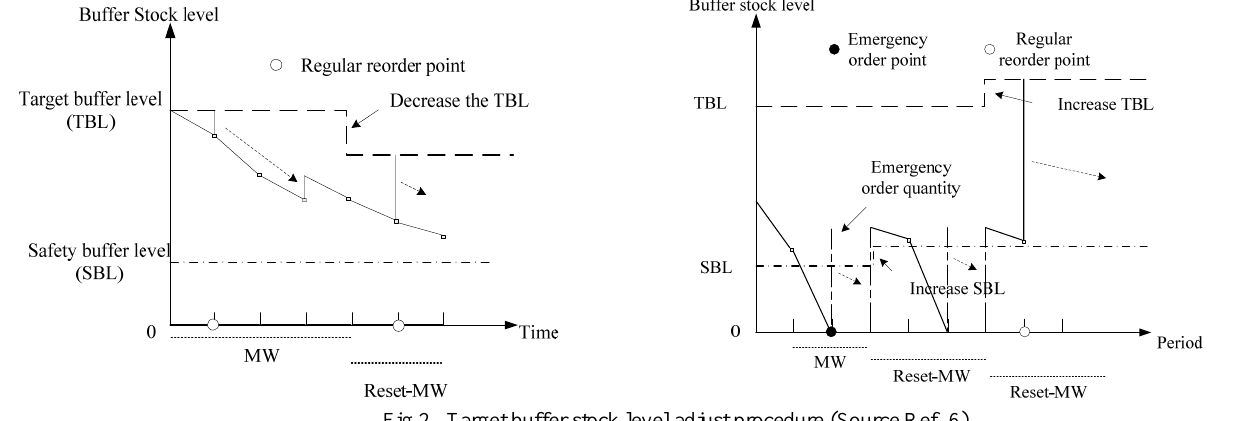
Fig.2. Target buffer stock level adjust procedure (Source Ref.